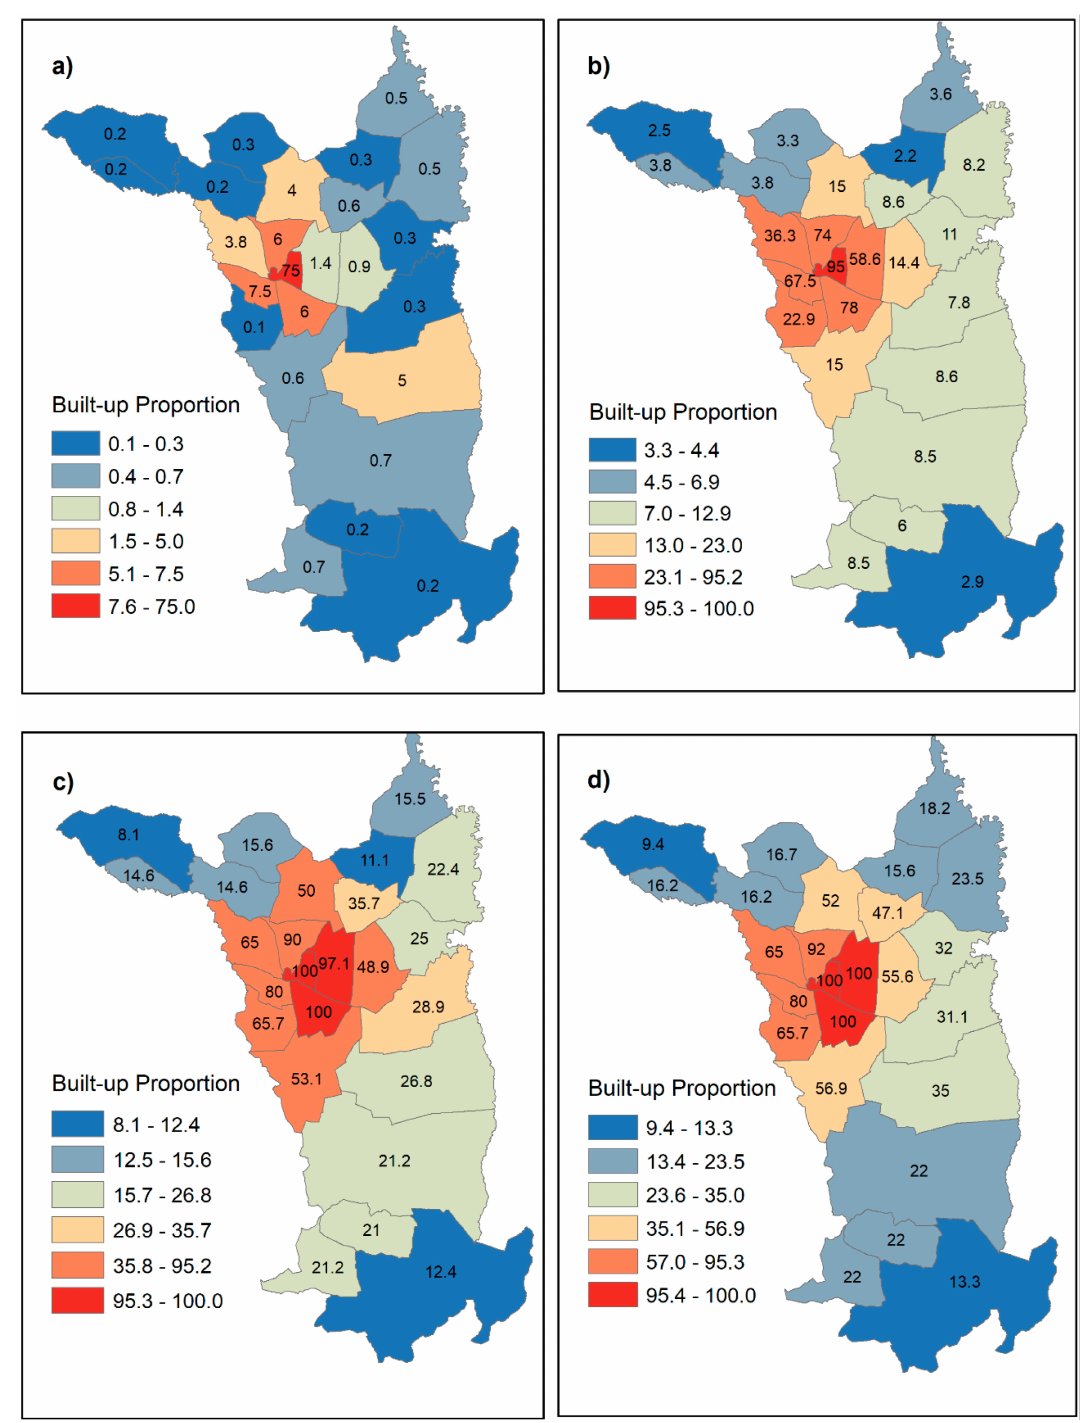
Figure 6. Proportions of built-up area for the total area of each district in 1972 ( a ), 2000 ( b ), 2015 ( c ), and 2050 ( d ). Figure 7 shows the change rate of built-up areas extent from 1990–2000 (a), 2000–2015 (b), and 2015–2050 (c) in every district, with all districts exhibiting urban expansion from 1990– 2000. During the 2000–2015 period, urban expansion continued in all districts, except for Hashmyah district as its land was completely developed. From 2000–2015 the majority of districts exhibited an urban increase at twice the rate of 1990–2000. No urban expansion is expected in five districts (Hashmyah, Nozha, Al-Barha, Al-Manarah, and Al-Rabiah) (Figure 7c) from 2015 to 2050, mainly because their lands would be completely